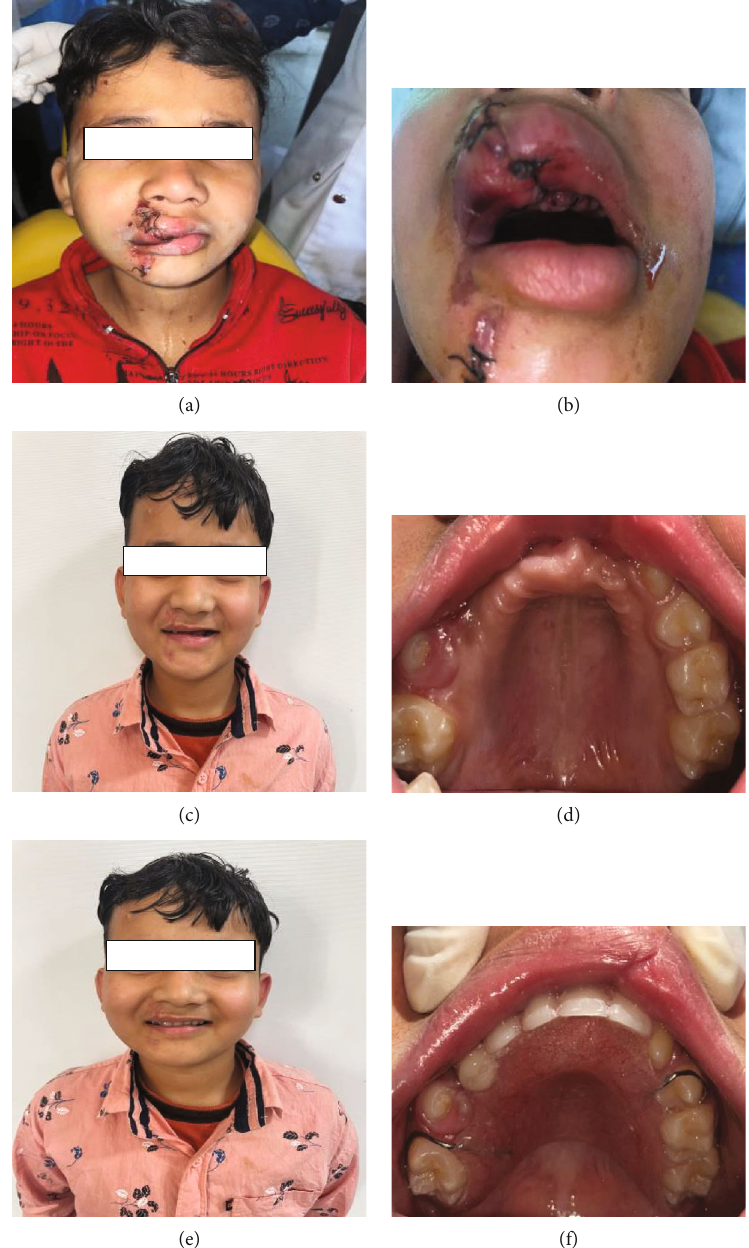
Figure 1: (a – f) Preoperative and postoperative (installation of removable prosthesis in the maxillary arch) photographs of the